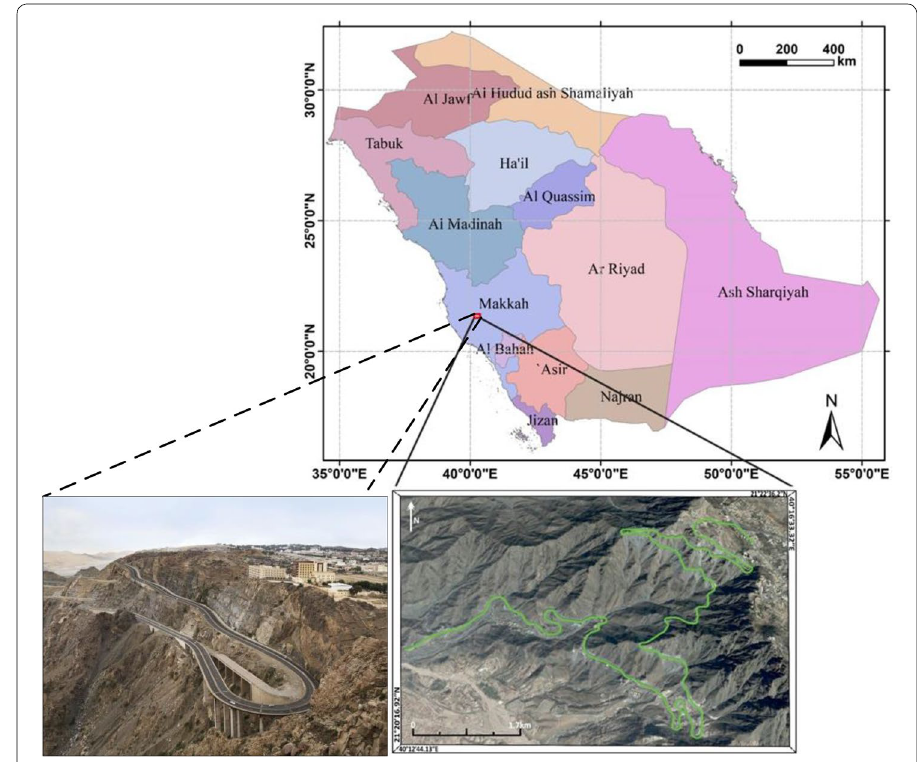
Fig. 1 Location of steep rock cut mountain road of Al-Hada